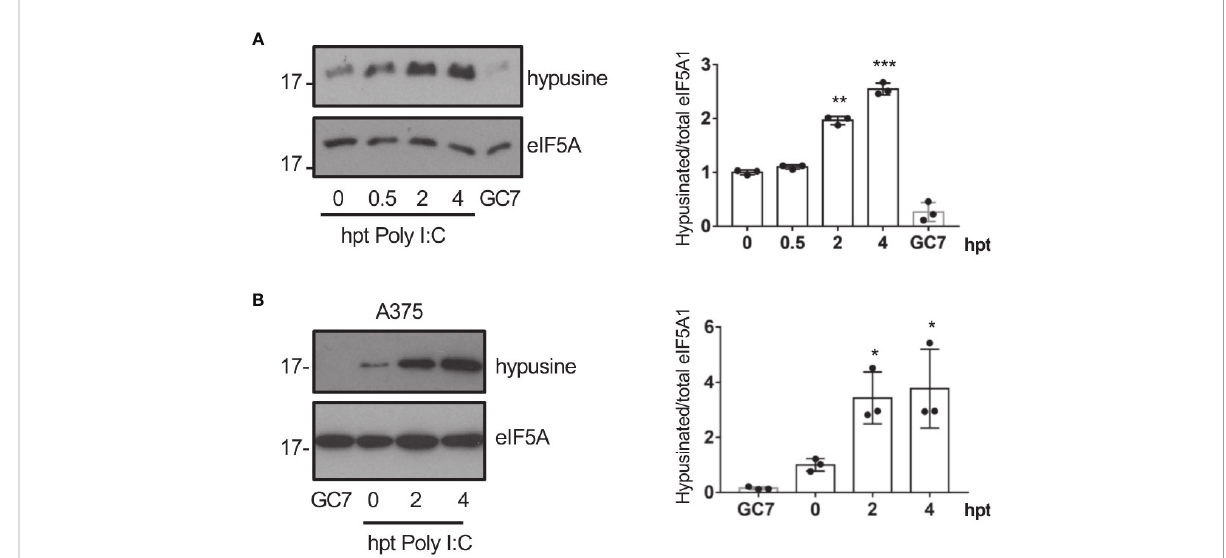
FIGURE 2 Transfection of dsRNA induces eIF5A activation. (A) , Activation of eIF5A in response to poly I:C transfection in A549 (A) or A375 (B) cells. Hypusinated eIF5A and protein intensity bands from three biological replicates were quanti fi ed using Image J software. Hypusinated/total eIF5A ratio from each respective time were plotted. Data represent the mean and error bars of three biological replicates (right panel). Statistical analysis was assessed by a Student ’ s t-test. *, P < 0.05, **, P < 0.005; ***, P < 0.0005. B, Activation of eIF5A in response to poly I:C transfection in A375